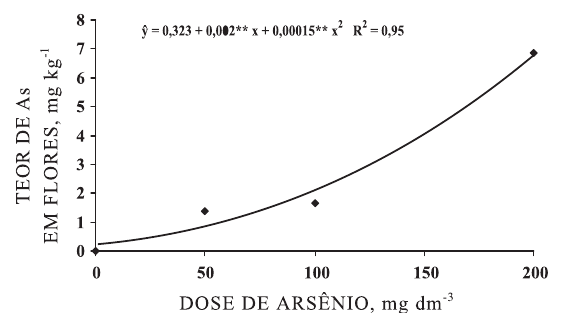
Figura 4. Teores de As em flores de plantas de aveia submetidas a diferentes doses de As cultivadas em amostras de um LVA de João